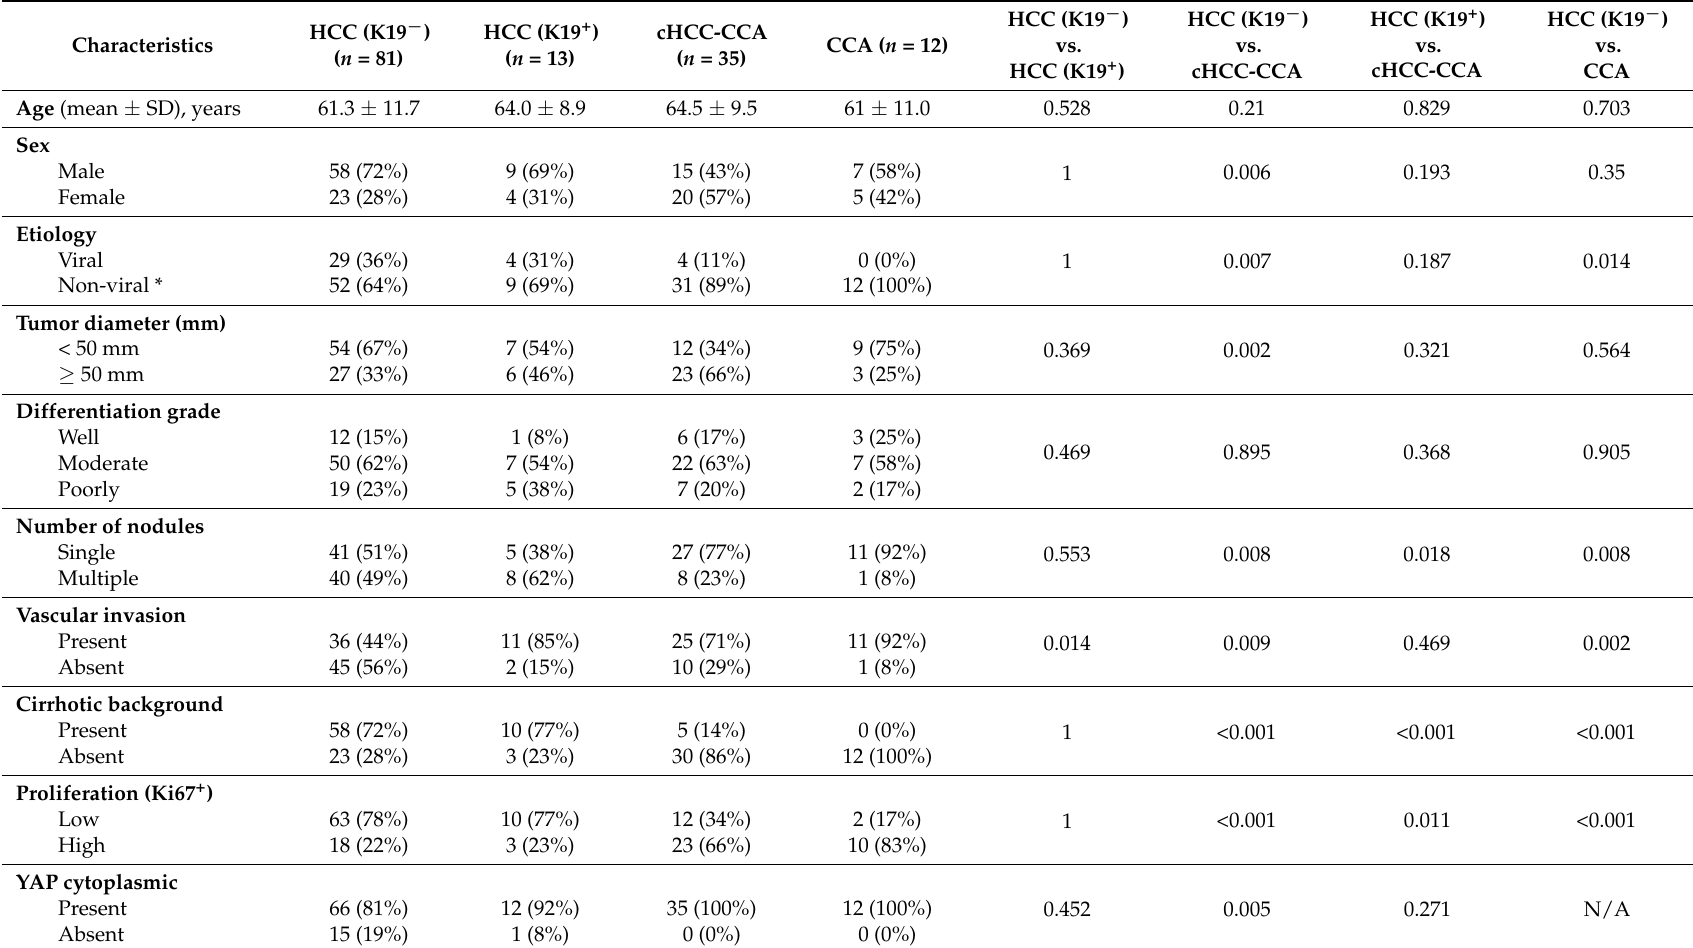
Table 1. Clinicopathological